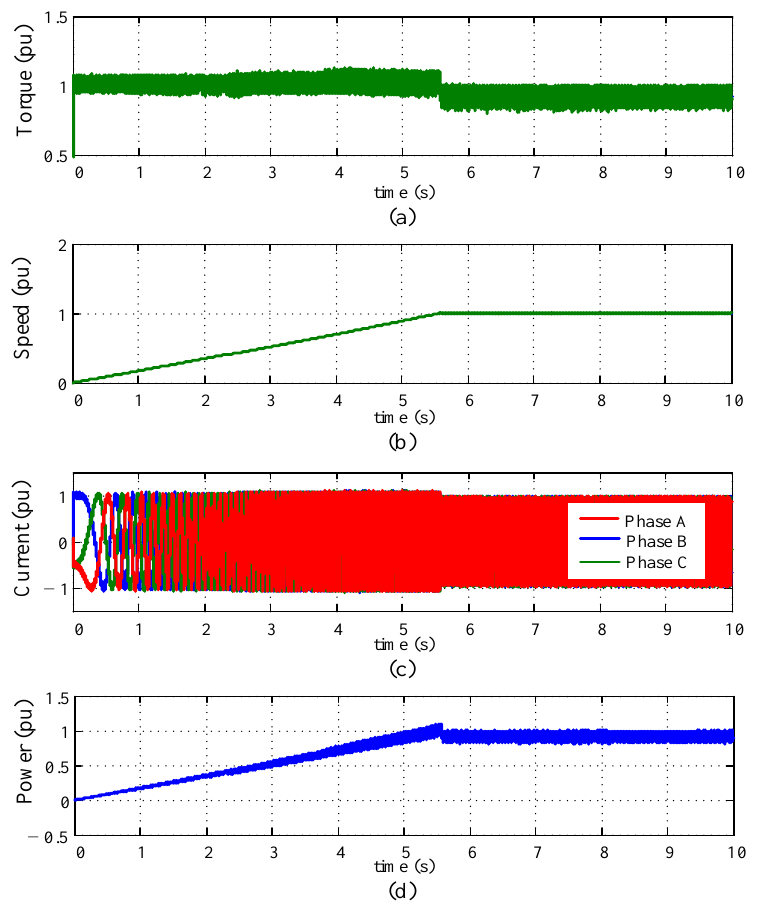
Figure 3. Simulation results of the propulsion system: ( a ) Torque of the propulsion motor; ( b ) Speed of the propulsion motor; ( c ) Phase currents of the propulsion motor; ( d ) Output power of the propulsion motor.